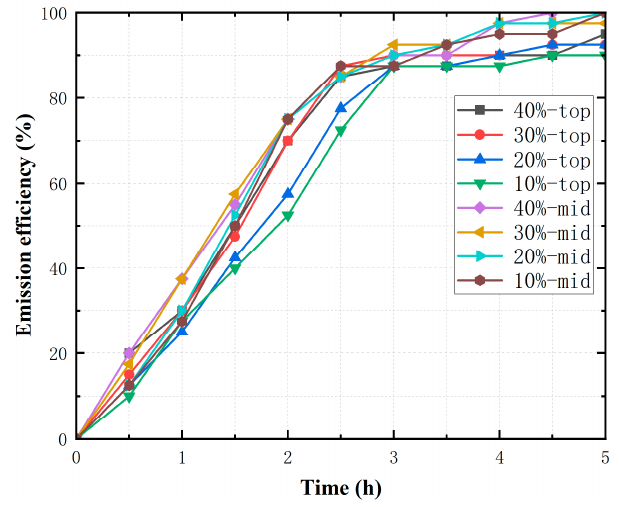
Figure 21. Comparison of emission efficiency at different injection positions.